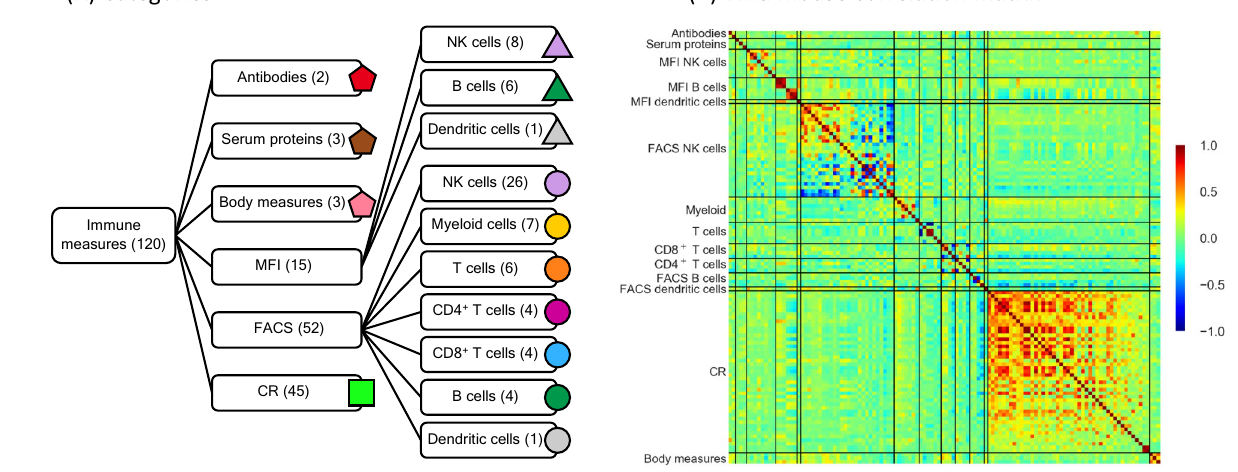
Figure 1. (A) Categories of immune measures. The numbers in the parentheses are the number of immune measures within that category. The symbol and colour associated with each category are used in the subsequent figures. The Mean Fluorescence Index (MFI) and Fluorescence Activated Cell Sorted (FACS) categories are divided into three and seven sub-categories, respectively. (B) Correlation matrix (coloured on a − 1 to + 1 scale) ordered according to the categories of immune measures for wild mice as shown in (A) . The solid black lines separate different categories of immune